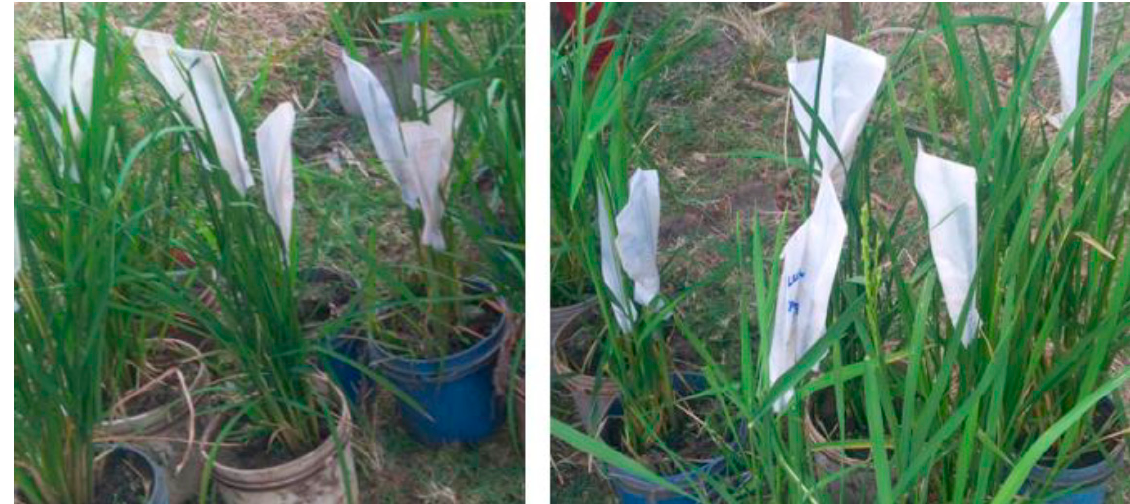
Figure 1. Emasculated and pollinated rice genotypes covered with pollination bags.